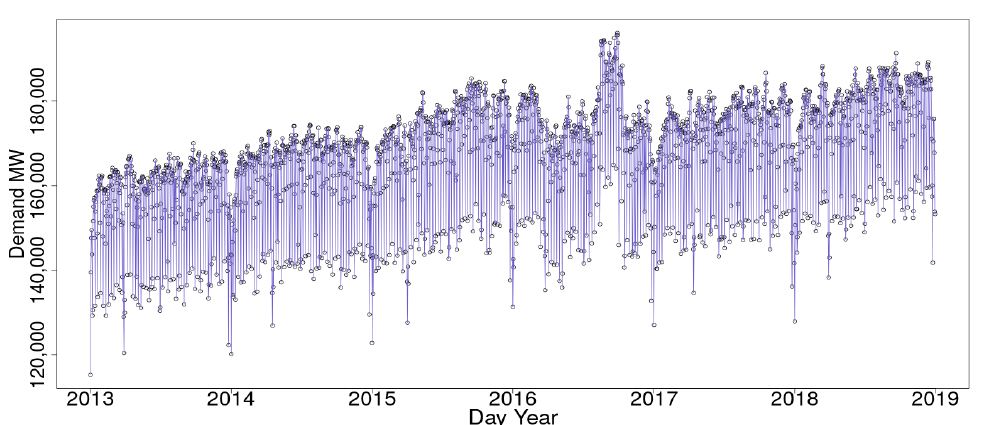
Figure 3. Unsmoothed data from January 2013 to December